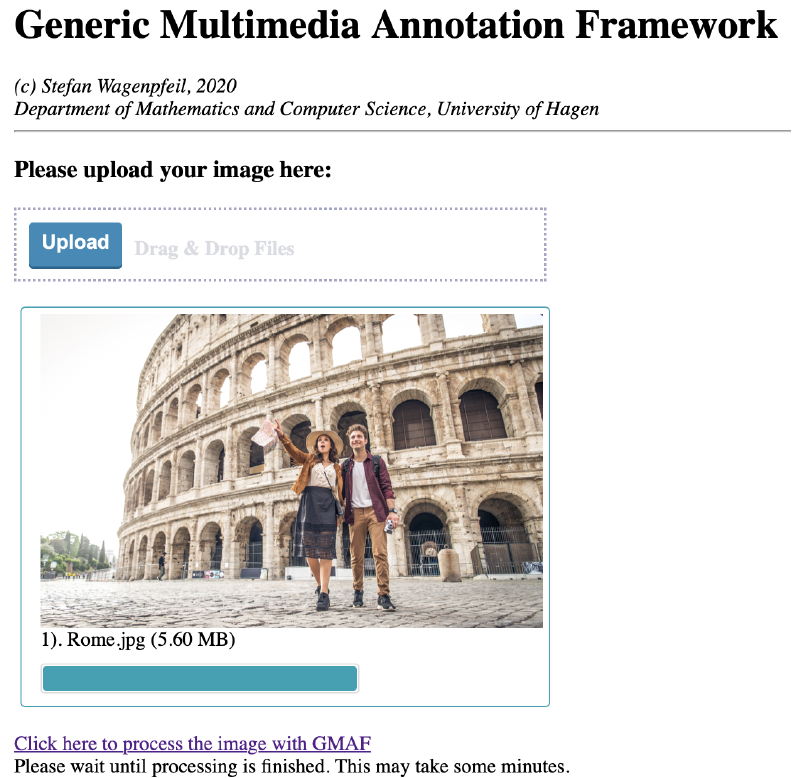
Figure 11. GMAF Web application with uploaded image of Rome.